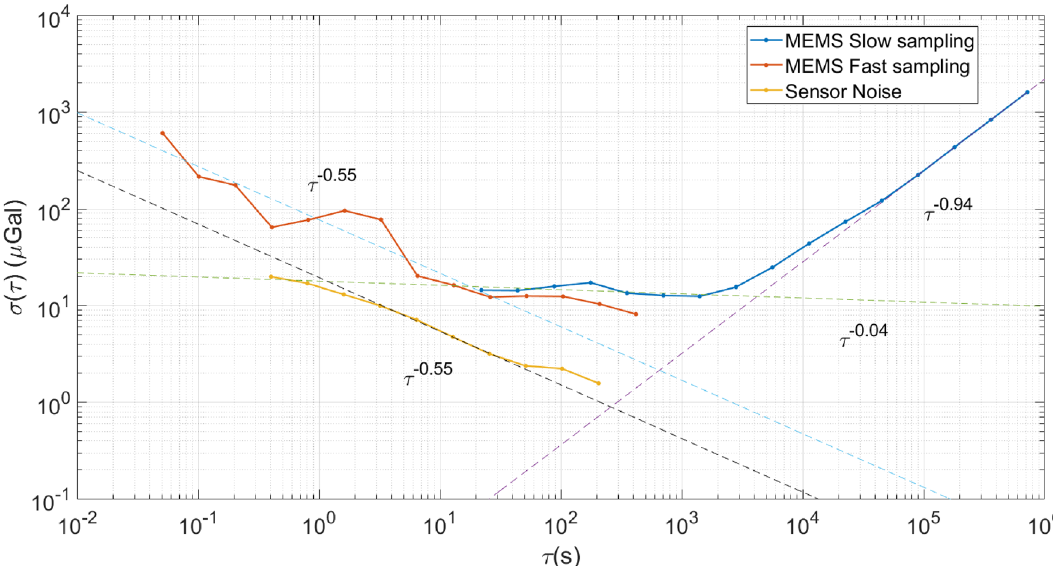
Figure 4. The Allan Deviation (AD) plots for the raw slow sampled MEMS data (the blue series), the raw fast sampled MEMS data (the orange series), and the sensor noise data (the yellow series). Dashed series are a result of fitting straight lines across different averaging periods for each data set. The slope of each fit is represented in the form of power-laws. Note: the small integration time ( τ ) data is not shown for the blue ( τ < 2 t slow 5.5 s) and the yellow series ( τ < 2 3 t fast , where, t fast = by the low-pass filtering